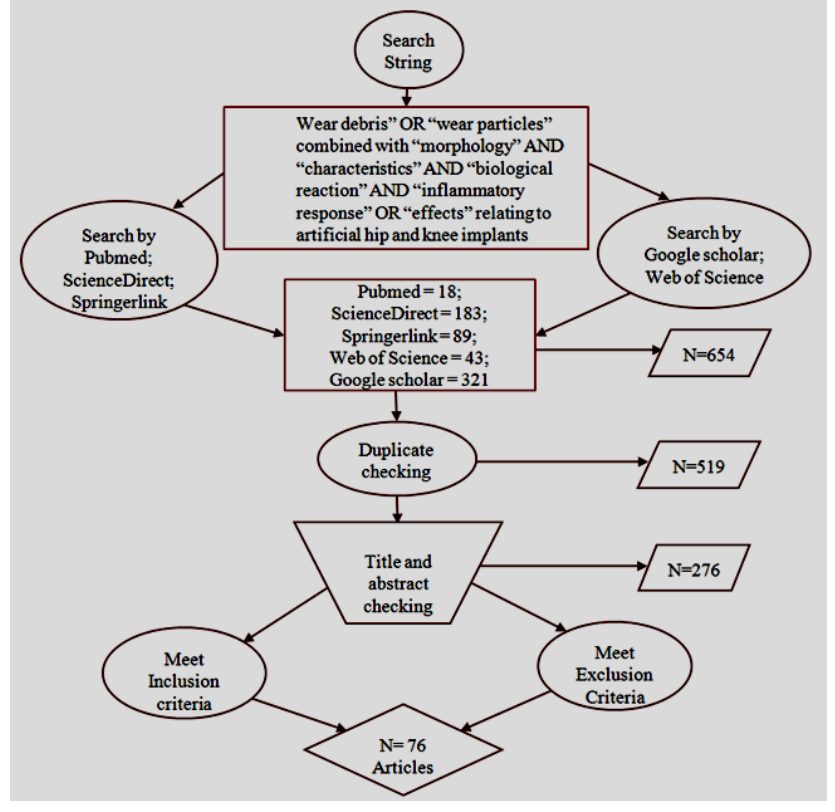
Figure 1. Flowchart illustrating the systematic search strategy of published peer-reviewed journals on wear-debris of hip and knee